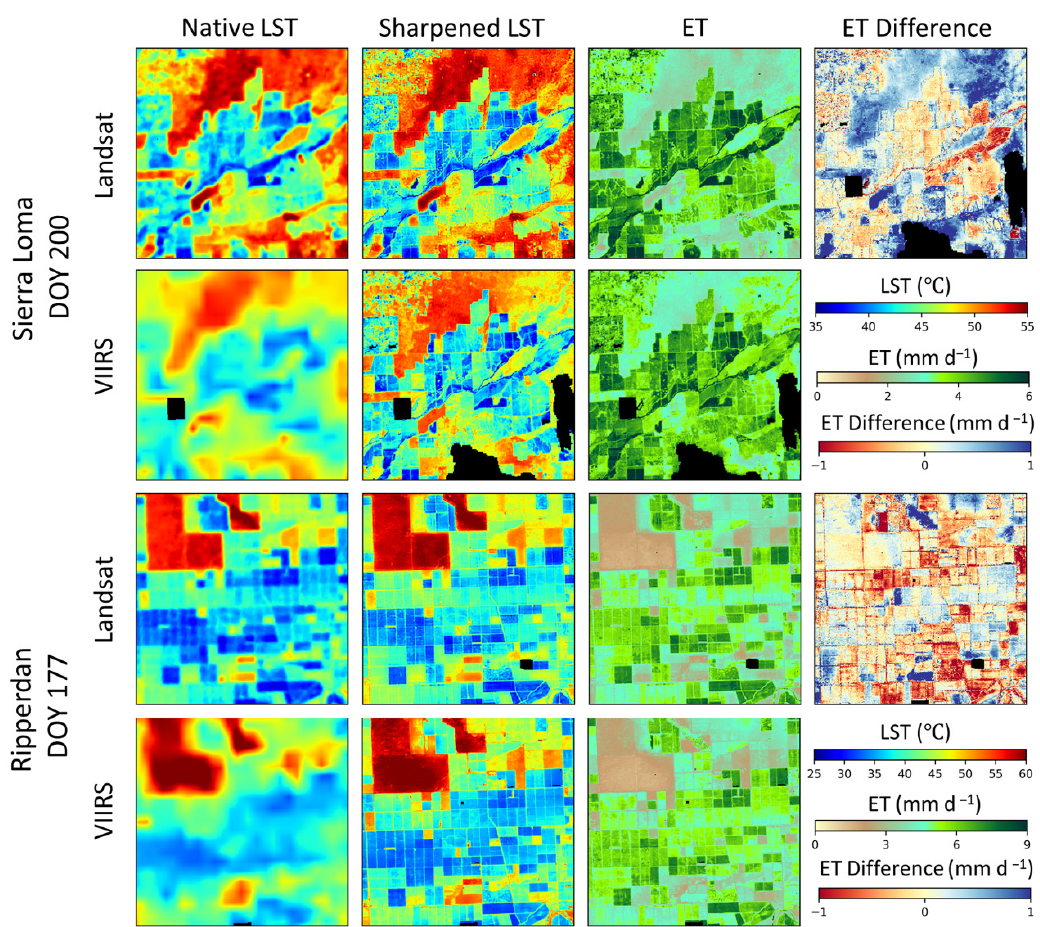
Figure 6. Comparison in spatial pattern of native LST ( ◦ C; first column), sharpened LST ( ◦ C; second column), and daily ET estimates (mm d − 1 ; third column) between Landsat and VIIRS-S2 on DOY 200 over Sierra Loma domain (top two rows) and DOY 177 over Ripperdan domain (bottom two rows). Daily ET difference maps (VIIRS-S2 minus Landsat) are shown in the fourth column.